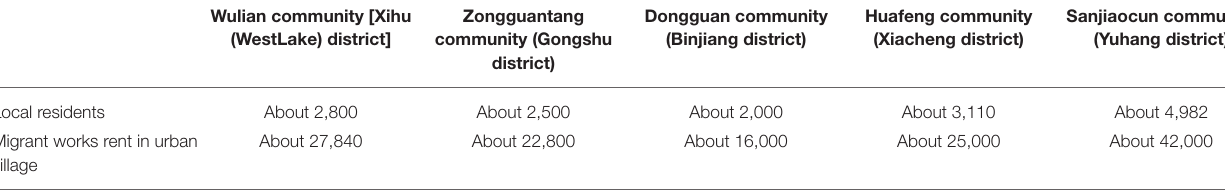
TABLE 1 | The number of the local residents and migrant workers in urban village we surveyed.